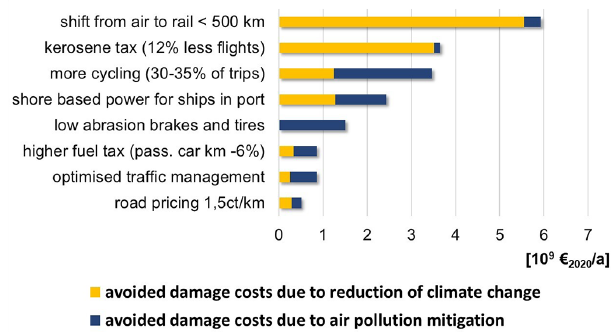
Figure 20. Ranking of measures in transport according to their ef- fectiveness in mitigating damage from air pollutant and greenhouse gas emissions in 2019. Recalculation of results of Friedrich (2016) with abatement costs of EUR 2020 118 per avoided tonne of CO 2 , eq as recommended in Sect.